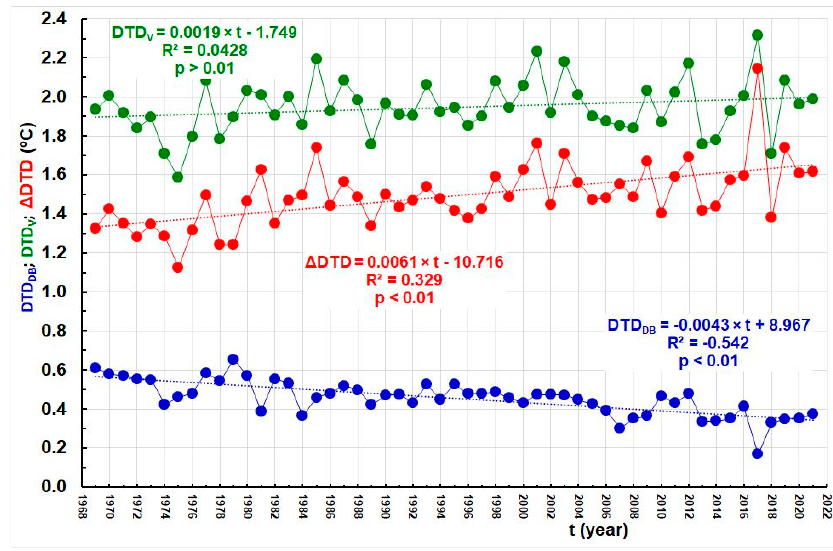
Figure 5. Series of annual values of water temperatures day-to-day, DTD DB , air temperature, day after day, DTD V , and their differences, Δ DTD = DTD DB − DTD V , from 1969–2021.